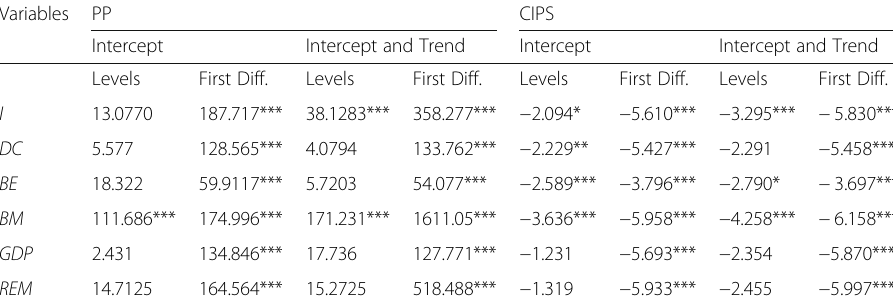
Table 5 Unit root test results (b) Variables PP CIPS Intercept Intercept and Trend Intercept Intercept and Trend